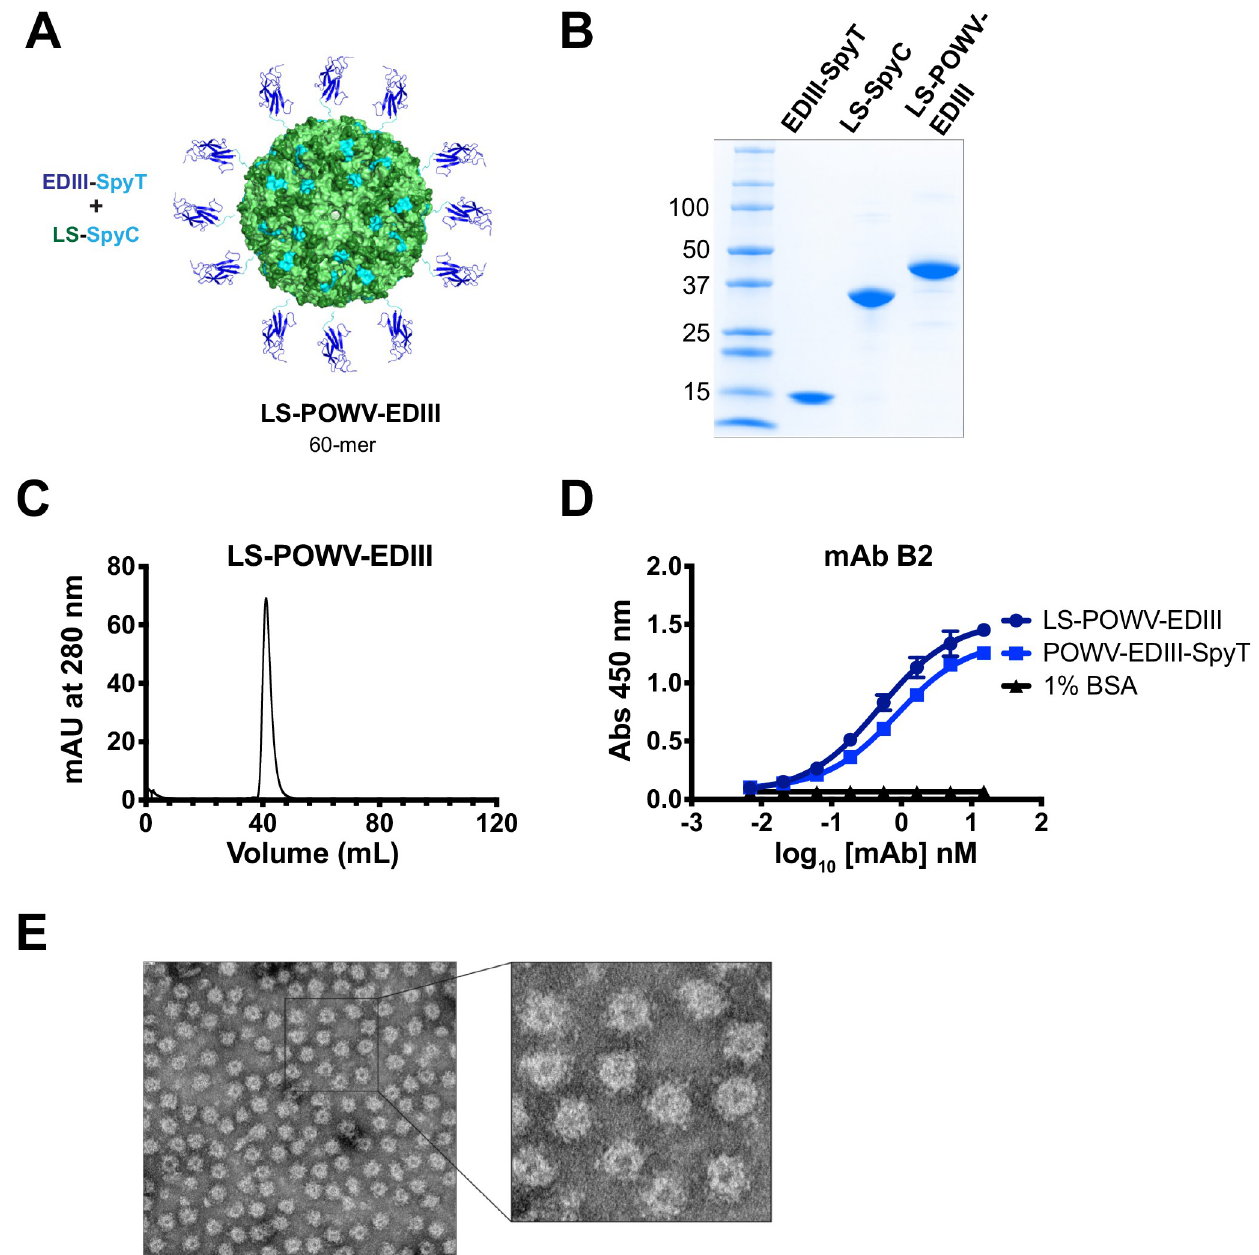
Fig 2. Production and characterization of LS-POWV-EDIII nanoparticle immunogen. ( A ) Schematic representation of LS-POWV-EDIII nanoparticle. Structures of LS (PDB: 1HQK; green) and POWV EDIII (blue) are covalently linked via SpyCatcher/SpyTag (cyan). ( B ) Coomassie stained SDS-PAGE gel of POWV EDIII nanoparticle conjugation using SpyCatcher/SpyTag system. Purified POWV EDIII-SpyT (12.6 kDa), LS-SpyC (32 kDa), and conjugated LS-POWV-EDIII (45 kDa) are shown. ( C ) Size exclusion chromatogram of LS-POWV-EDIII. Sample was run on Sephacryl S-400 HR AKTA column. A retention time of 45 mL was observed (MW 1x10 6 -1x10 7 Da). ( D ) ELISA reactivity of mAbs B2 toward POWV EDIII-SpyT and LS-POWV-EDIII. ELISAs were performed twice independently in triplicate wells (mean ± SD). ( E ) Negative-stain transmission EM images of LS-POWV-EDIII. Scale bar is 50 nm.